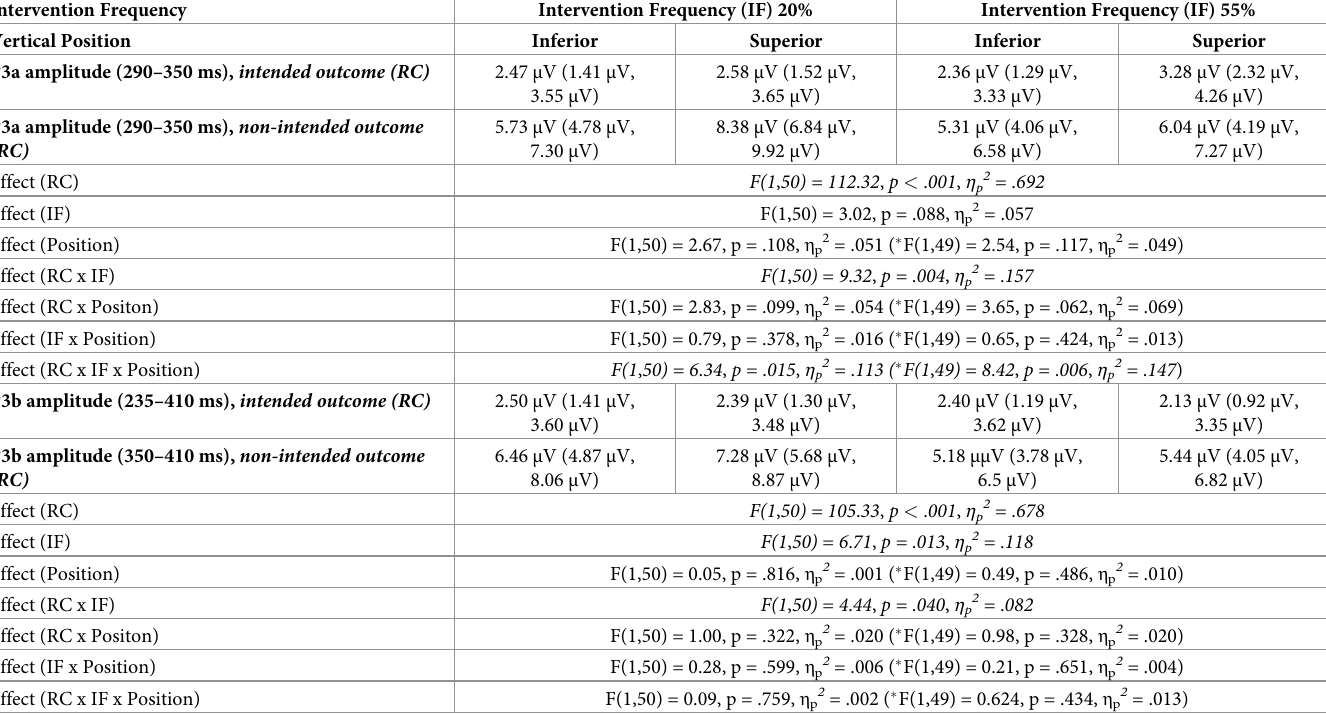
Table 2. Descriptive statistics and ANOVA results for the ERP data, separated for intervention frequency (IF, 20% vs. 55%), group assignment (vertical position: inferior vs. superior), and outcome of ball though (RC, intended vs. non-intended recipient). To each mean value, the upper and lower limits of confidence intervals (95%) are additionally provided. ANOVA results for the factor vertical position are additionally controlled for the covariate ’age of participant’ in an ANCOVA. All ANCOVA results are indexed by an asterisk ( �